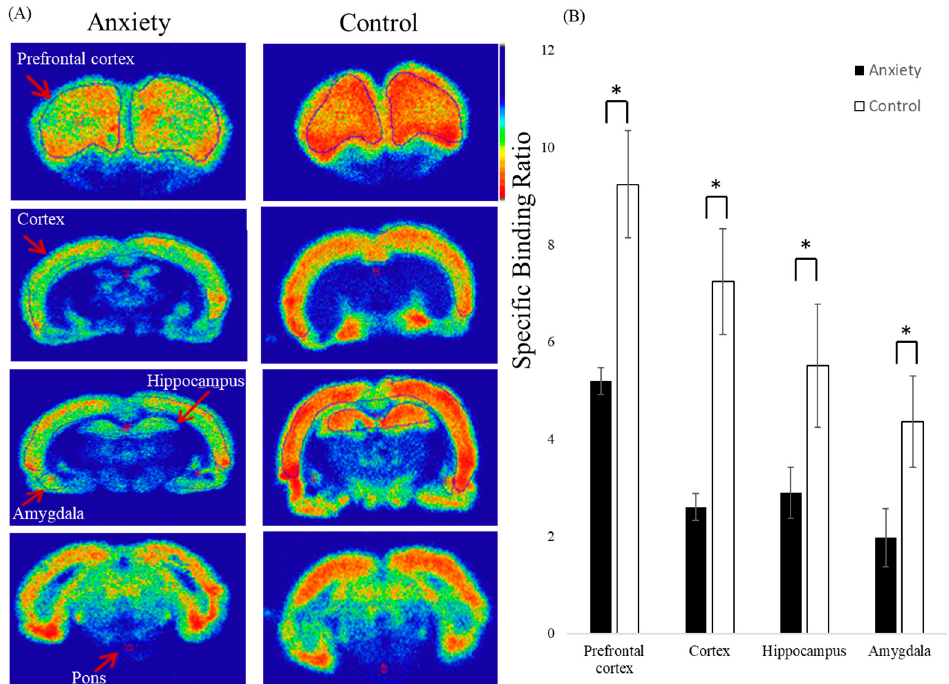
Figure 3. Ex vivo autoradiography of [ 18 F]flumazenil in fear-conditioned (anxiety group) and control rats. The autoradiograms of sections were taken 30 min post-injection of [ 18 F]flumazenil. ( A ) In comparison with control rats, the fear-conditioned rats displayed lower accumulation of [ 18 F]flumazenil in the prefrontal cortex, cortex, amygdala, and hippocampus. ( B ) The normal rats displayed markedly higher specific binding ratios than the fear-conditioned rats in prefrontal cortex, cortex, hippocampus, and amygdala ( p < 0.05, unpaired t test). Black = anxiety group, white = control group. (* p value < 0.05 compared to control group).